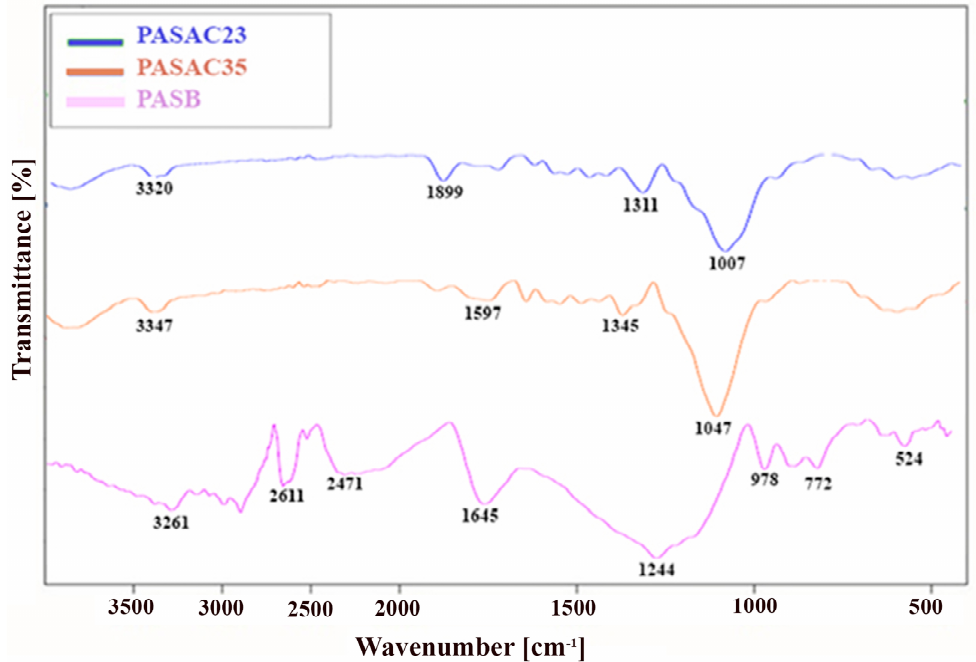
Figure 3. FT-IR spectra of PASB, PASAC23 and PASAC35.